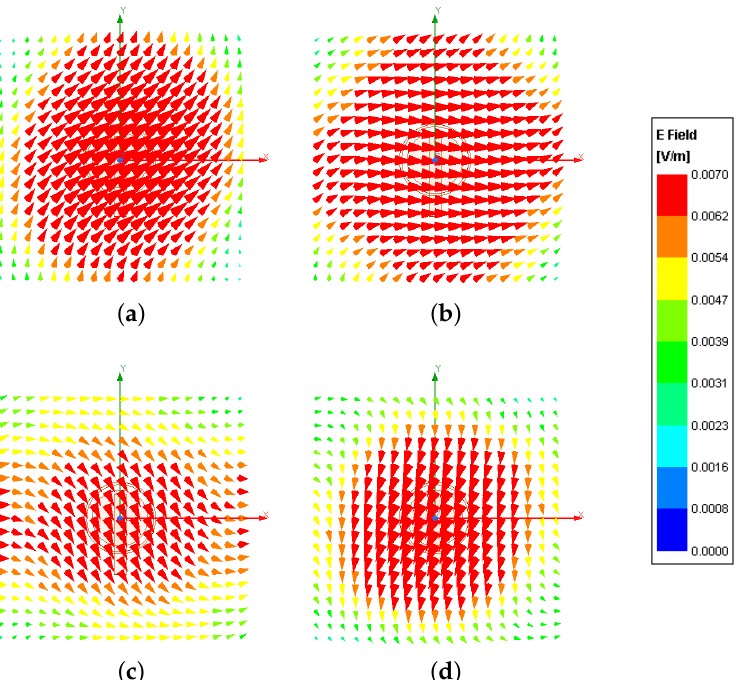
Figure 10. Numerical Assessment ( [ f min , f max ] = [ 2.3, 2.6 ] [GHz], f = f 0 = 2.45 [GHz])—Plot of the vectorial electric field at z = 10 λ 0 , E ( x , y ; t ) , at the time instants ( a ) t = 0 [sec], ( b ) t = T 0 T 0 [sec]. ( c ) t = T 0 [sec], and ( d ) t = 3 8 4